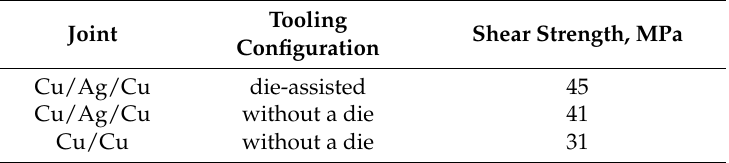
Table 1. Shear strength of Cu/Ag/Cu joints formed by passing electric current through a “Cu plate/Ag 2 C 2 O 4 /Cu plate” assembly in the configurations with and without a die and a Cu/Cu joint. Refer to the text for details of the joining